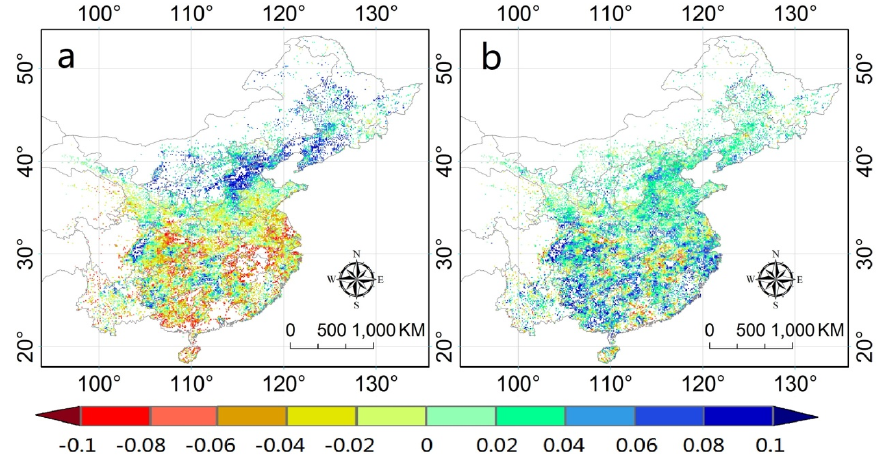
Figure 4. The spatial pattern of the bias contained in ( a ) un-calibrated IMERG and ( b ) calibrated